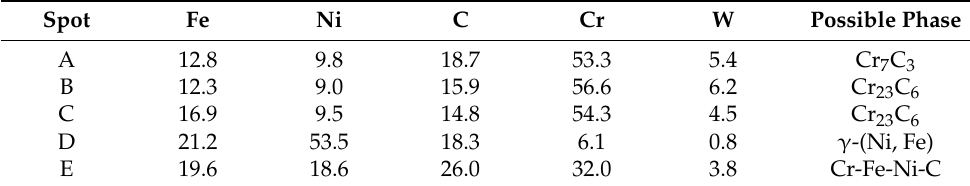
Figure 3. SEM images of surface microstructure of Ni-based composite coatings with different NiGNPs content: ( a ) 0, ( b ) 10%, ( c ) 20%, ( d ) 30%. NiGNPs content: ( a ) 0, ( b ) 10%, ( c ) 20%, ( d ) 30%. Table 4. EDS results of each point shown in Figure 3 (at, %). Table 4. EDS results of each point shown in Figure 3 (at